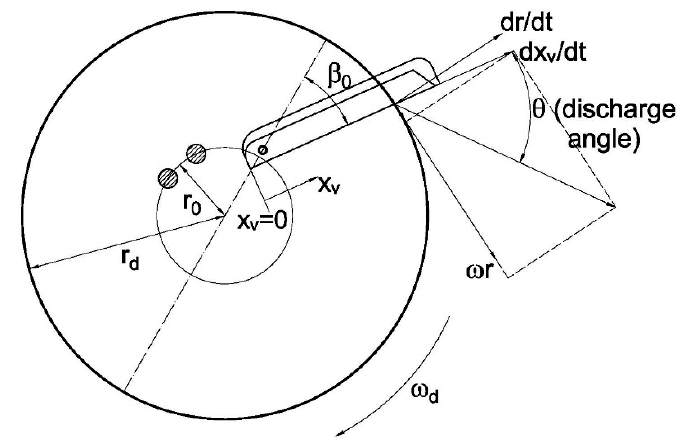
Figure 1. Geometry, kinematics, and dynamics of a spinning disc fertilizer.